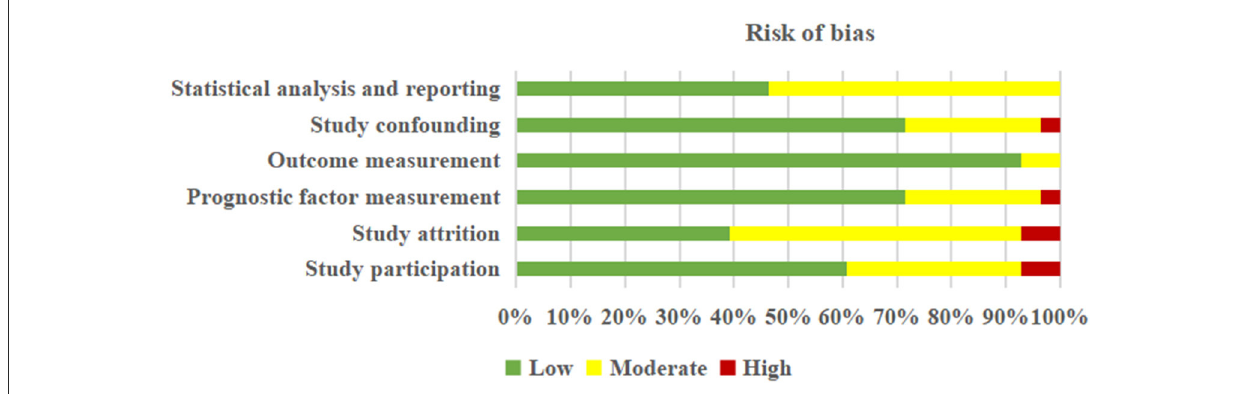
FIGURE2 Summarized risk of bias in the 28 included studies according to the QUIPS criteria.